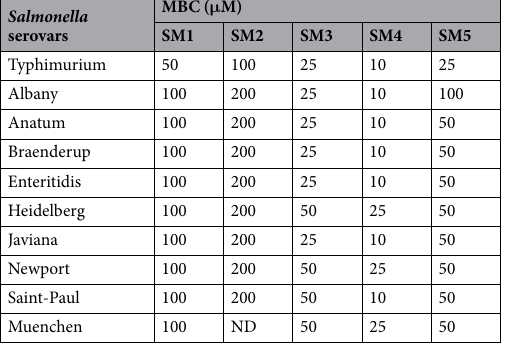
Table 1. Antimicrobial efficacy of the selected five small molecules (SMs) on different Salmonella enterica serotypes. ND: not determined; MBC: minimal bactericidal